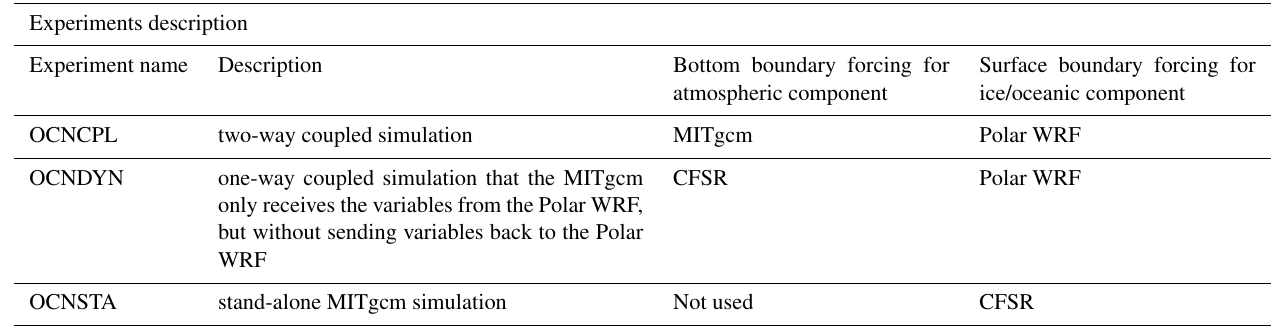
Table 3. The initial conditions, boundary conditions and forcing terms used in the experiments. Experiments description Description Bottom boundary forcing for Surface boundary forcing for atmospheric component two-way coupled simulation MITgcm CFSR Polar WRF OCNDYN one-way coupled simulation that the MITgcm only receives the variables from the Polar WRF, but without sending variables back to the Polar WRF OCNSTA stand-alone MITgcm simulation Not used